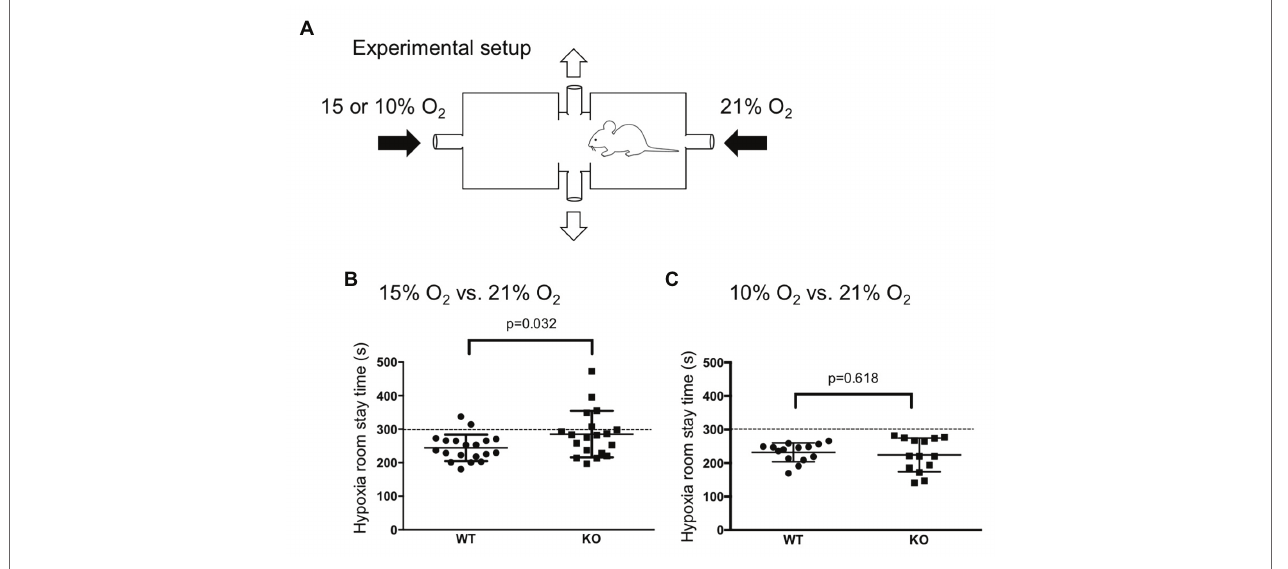
FIGURE 2 | Hypoxia avoidance test. (A) Illustration of an apparatus to create an oxygen concentration gradient in which a mouse can move back and forth (see method section for detail). (B,C) WT mice ( n = 19) avoided both mild (15% O 2 , B ) and severe (10% O 2 , C ) hypoxia whereas knockout (KO) mice ( n = 19) avoided only severe hypoxia. The dotted lines at 300 s indicates chance level during the observation period of 10 min. Horizontal lines indicate mean and SEM. The difference between the two genotypes was assessed using the Student’s t -test, and value of p is